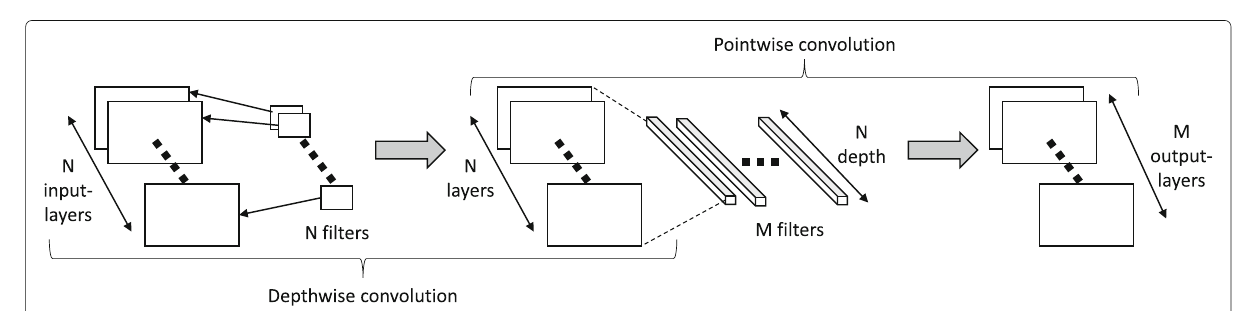
Fig. 4 Overview of a single depthwise separable convolutional layer consisting of a depthwise convolution followed by a pointwise convolution. (1) The depthwise convolution separately applies a 2-dimensional filter to each of the channels in the input, extracting time-frequency patterns. (2) The pointwise convolution then applies a number of 1-dimensional filters to the output of the depthwise convolution across all